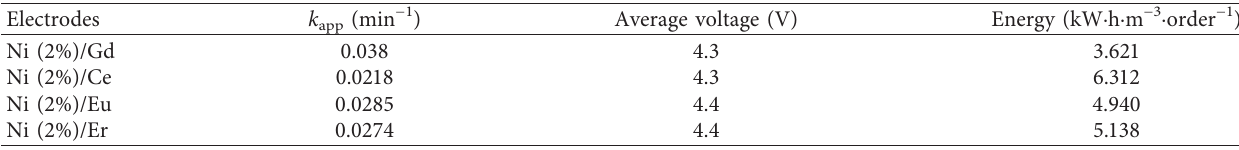
Table 13: Energy per order of decolorized 100mg · L − 1 RhB solution, evaluated from equation (5), and electrochemical decolorization of Ti/ SnO 2 -Sb-Ni/Re electrodes with Ni (2%) content and different rare earth elements in 200 ml dye solution.